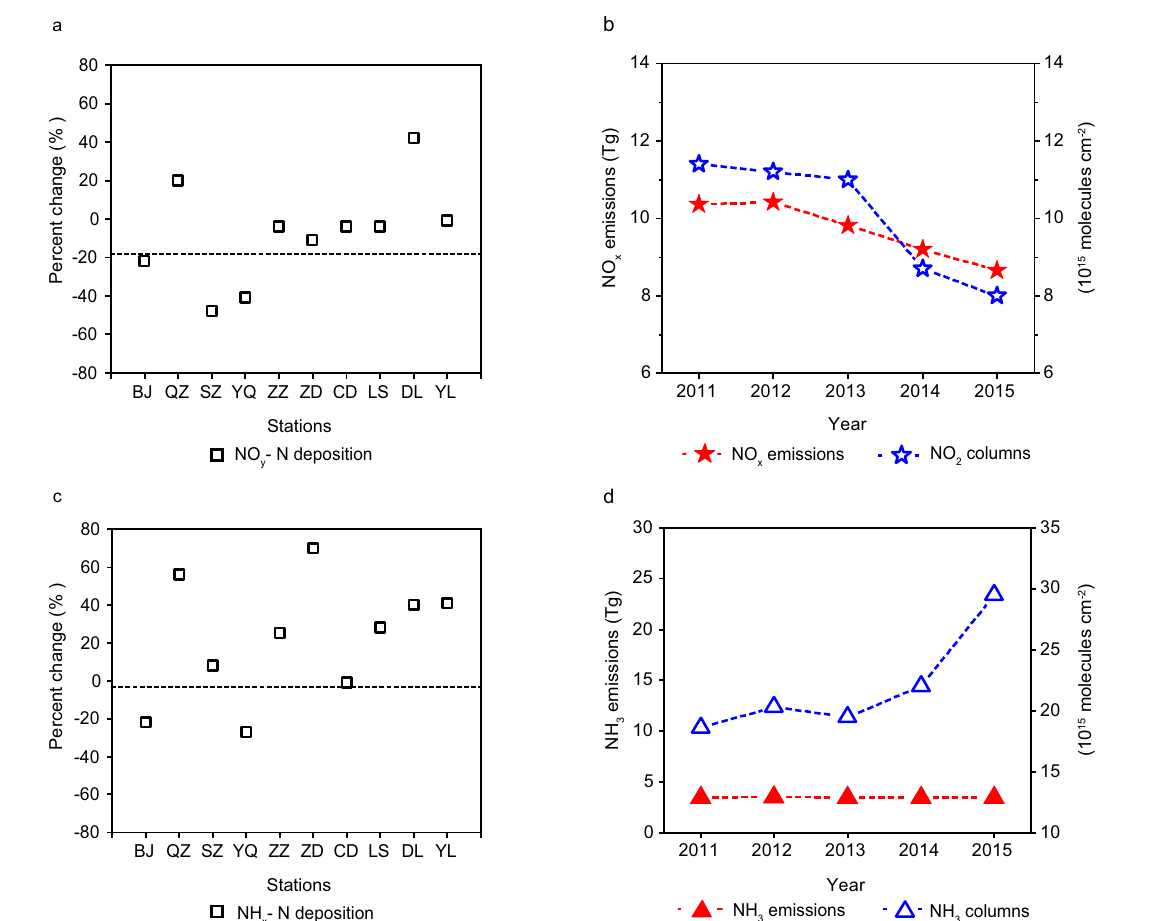
Fig. 1 The inter-annual variations of observed reactive N deposition fl uxes and the precursor emissions and column concentrations in Eastern China during 2011 ‒ 2015. a The temporal changes (%) of observed annual NO y -N deposition fl uxes at each of the ten stations in Eastern China (the locations are marked in Fig. 2) from 2011 to 2015; the horizontal dashed line ( − 18%) denotes the tendency of annual NO x emission in Eastern China from 2011 to 2015. b The inter-annual NO x emissions and observed region-averaged NO 2 columns for Eastern China. c The percent changes of NH x -N deposition fl uxes from 2011 to 2015 at observation sites; the dashed line denotes the tendency of regional NH 3 emission. d The inter-annual NH 3 emissions and observed region- averaged NH 3 columns for Eastern China. The deposition observations were derived from ref. 24 . The ten observational stations are Beijing (BJ), Quzhou (QZ), Shangzhuang (SZ), Yangqu (YQ), Zhengzhou (ZZ), Zhumadian (ZD), Changdao (CD), Lingshandao (LS), Dalian (DL), and Yangling (YL). The NO x emissions were derived from ref. 9 . The NH x -N emissions and column concentrations were derived from ref. 29